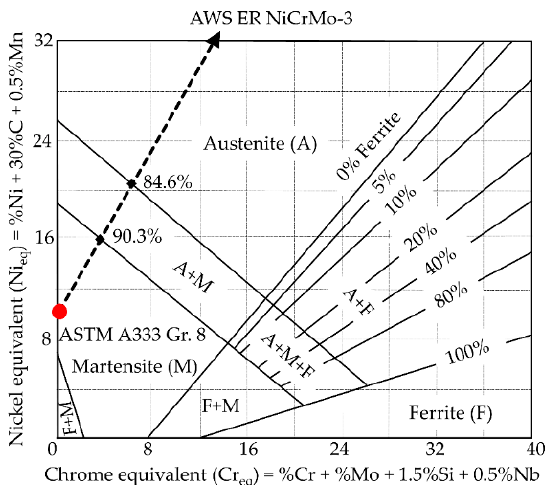
Figure 4. Schaeffler diagram shows the formations of martensite and the composite zone (martensite and austenite) in the transition zone of the substrate/clad for high dilutions levels.